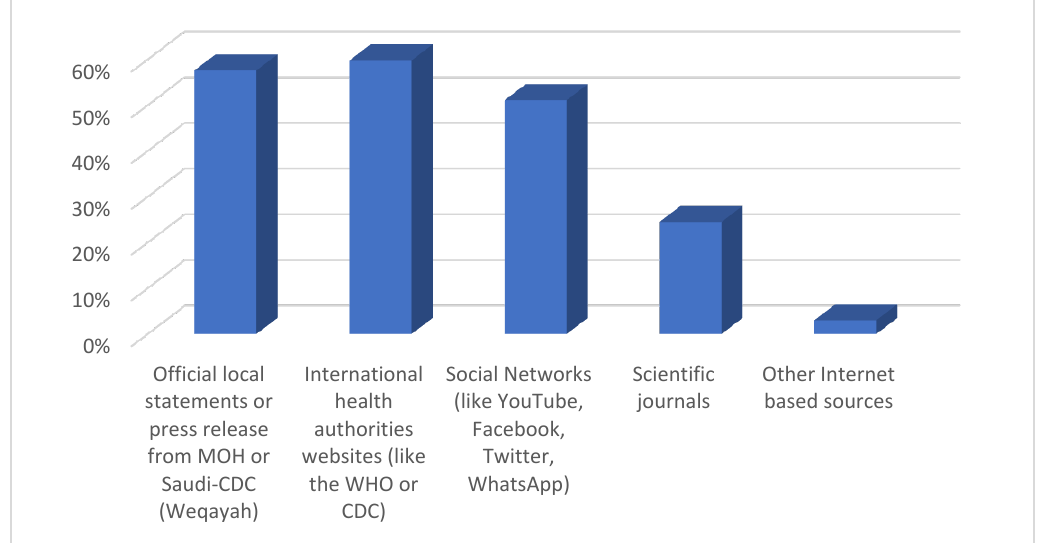
Figure A3. HCWs ’ sources of information about monkeypox disease. (KSA, 27 May to 5 June Figure A3. HCWs’ sources of information about monkeypox disease. (KSA, 27 May to 5 June 2022.)